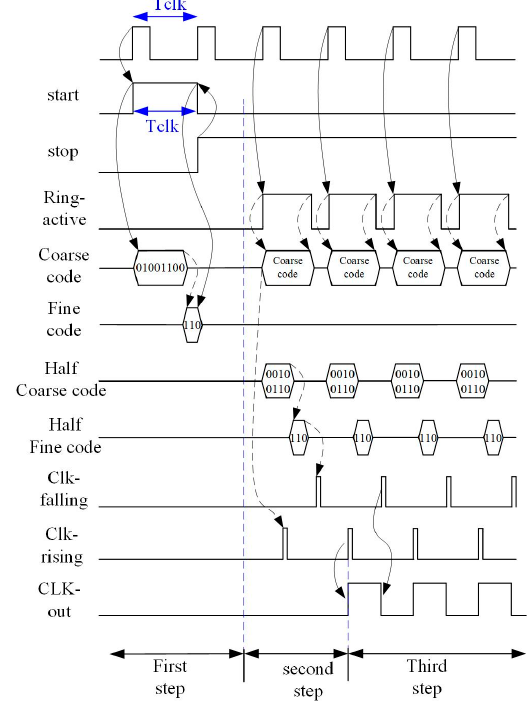
Figure 2. Timing diagram of the proposed ADDCC. (Tclk: Period of input clock.) 2.1. TDC The TDC is composed of the Fine TDC, and the Coarse TDC, as shown in Figure 3. The purpose of TDC is to quantize the period of input clock into digital code.